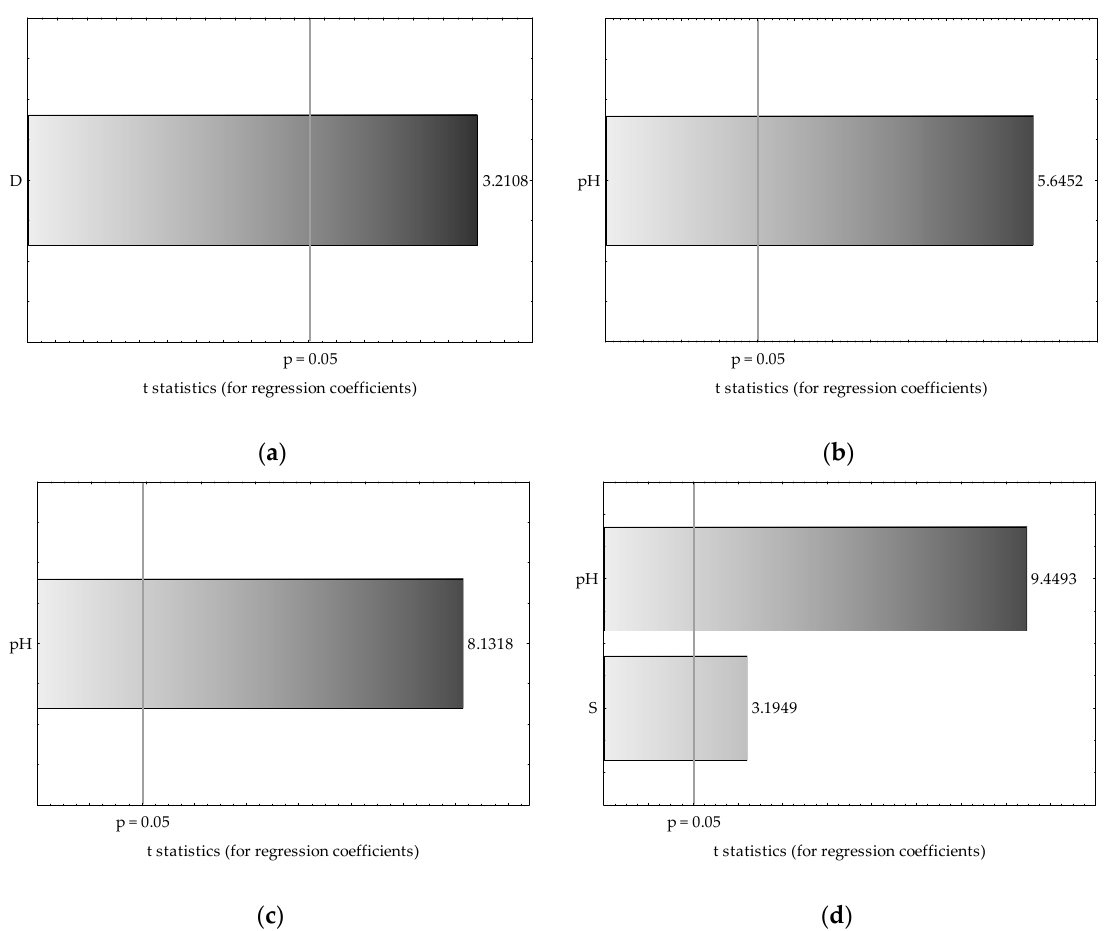
Figure 8. Pareto chart of t-values for the most significant regression coefficients in the developed regression models for Mn and Zn contents in very light ( a , b ) and heavy soils ( c , d ). Pareto chart contrasting t-values of regression coefficients accounting for the regression model with the significant p -value cut-off (vertical gray line).